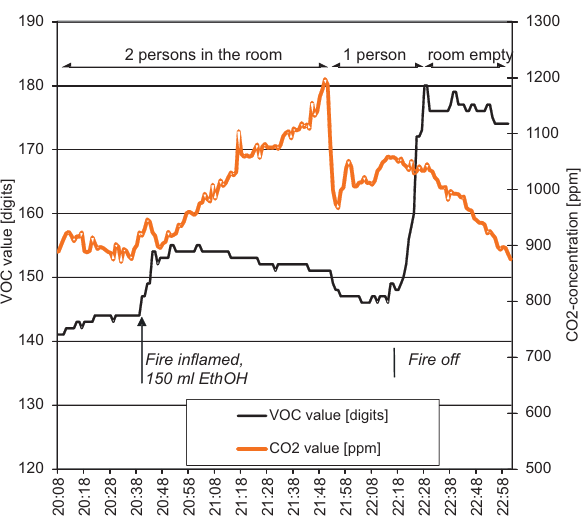
Figure 6. VOC and CO 2 measurements with an ethanol oven in a passive house living room with 159m 3 volume.